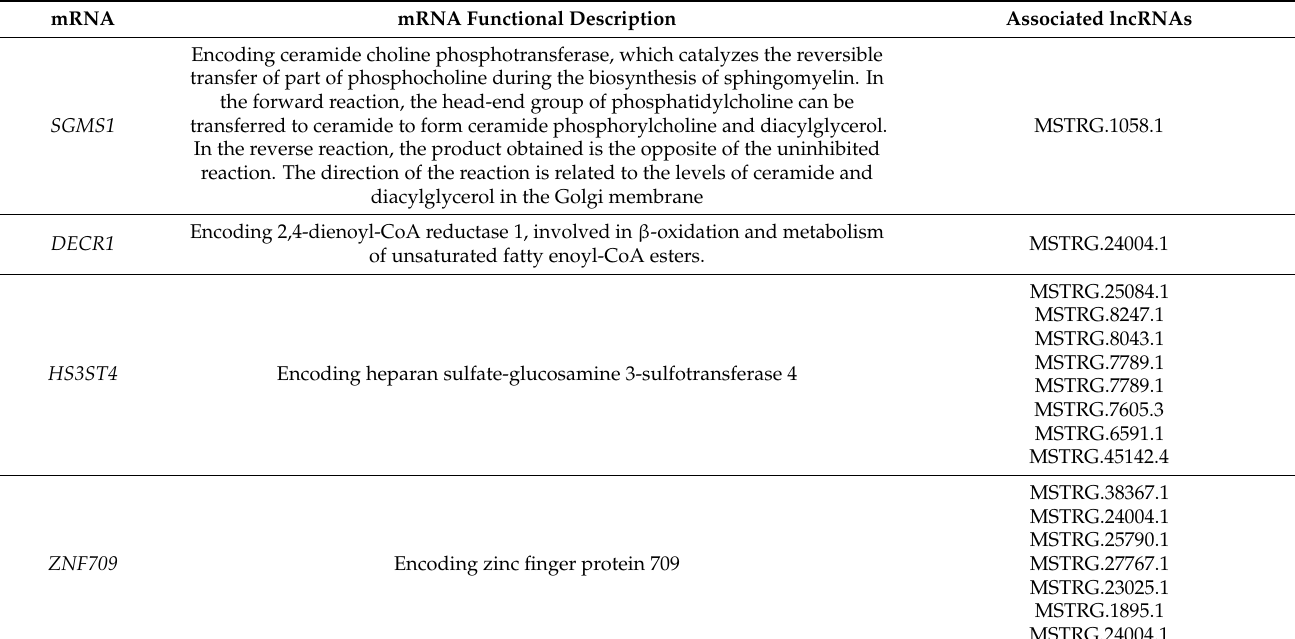
Table 5. The mRNA (target genes of lncRNAs) and associated lncRNAs in Module